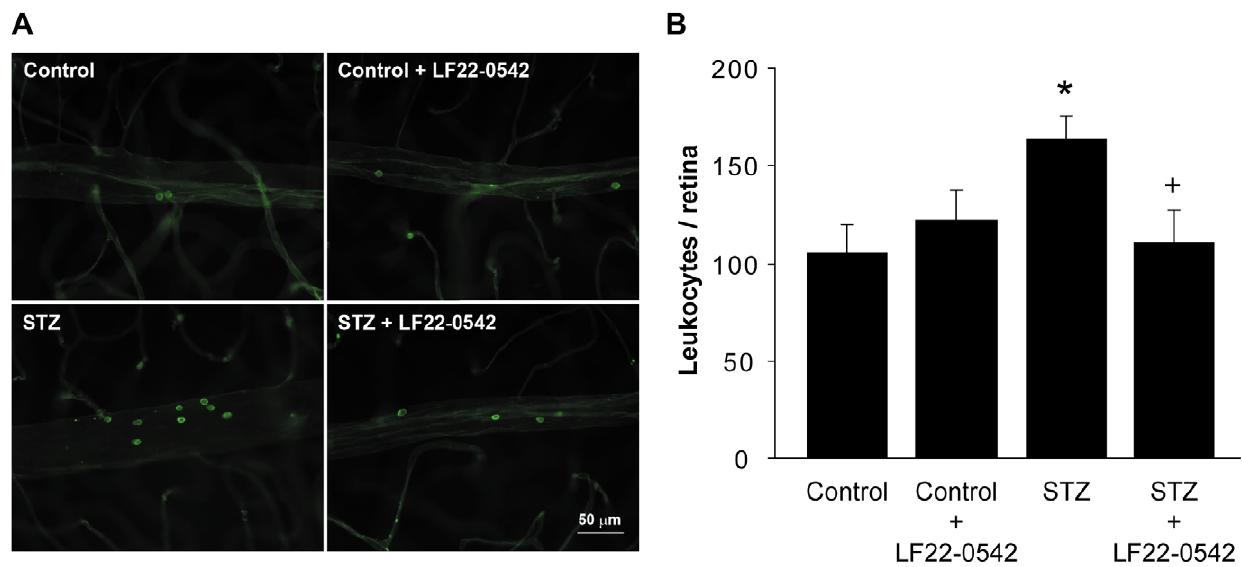
Figure 3. Effect of LF22-0542 on retinal leukostasis in STZ-diabetic rats. (A) Representative pictures of adherent leucocytes in retinal vessels of a control rat, a control rat treated with LF22-0542, a STZ-diabetic rat and a STZ-diabetic rat treated with LF22-0542. Scale bar is 50 m m. (B) Number of adherent leukocytes per retina. Data are mean 6 s.e.m. of values obtained from 5 to 7 rats in each group. Statistical comparison with control (*) or STZ ( + ) rats is indicated by * + P , 0.05.